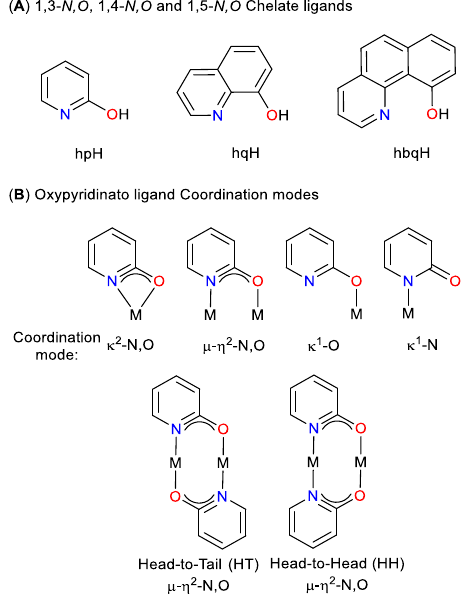
Figure 2. Overview of the N , O donor pro-ligands, hpH, hqH, and hbqH used in this study ( A ), and the common coordination modes observed for the 2-hydroxpyridinato (hp) ligand ( B ).